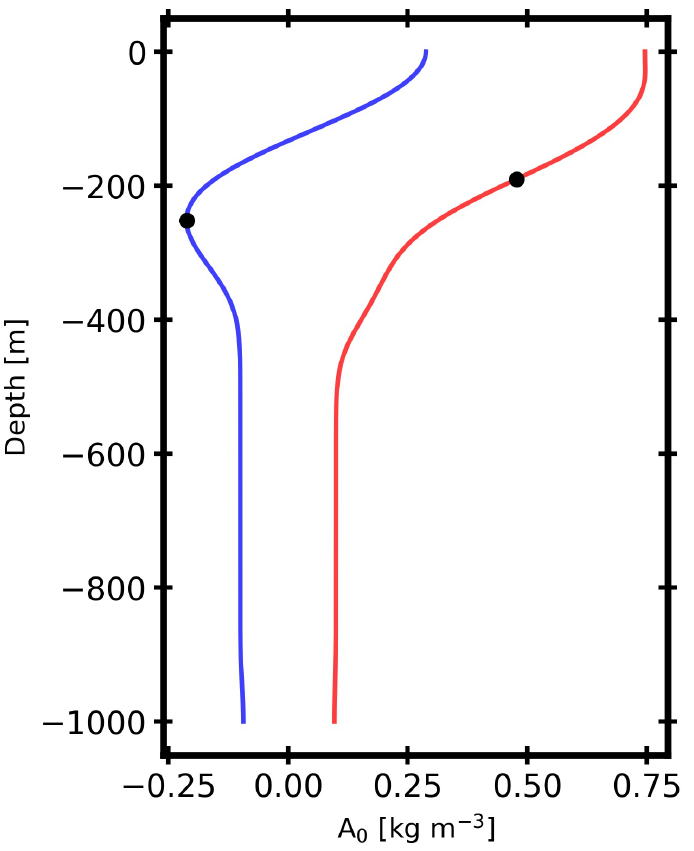
Figure 11. Density anomaly amplitude versus depth; the blue lines represent the AE amplitude and the CE is presented in red. The eddy depths are represented by black